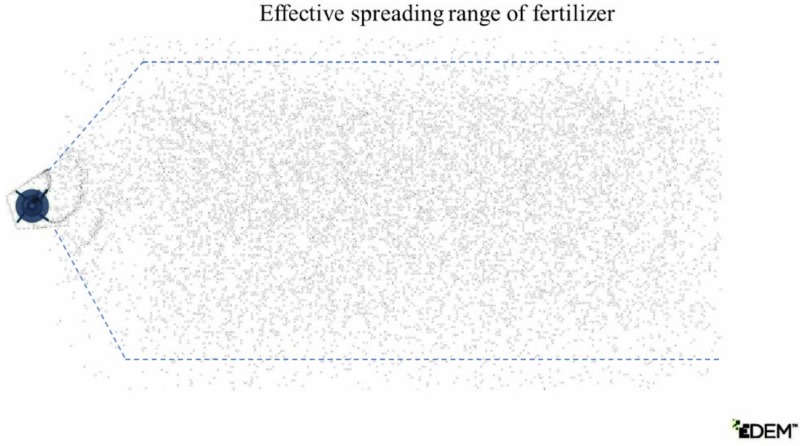
Figure 16. Fertilizer distribution of centrifugal disc